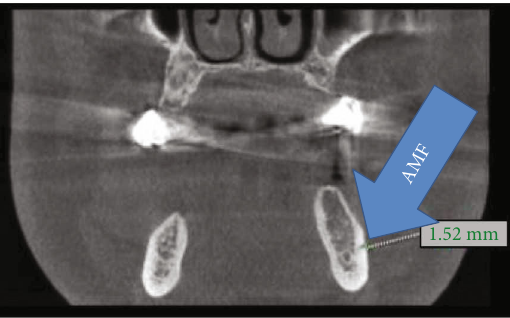
Figure 5: Left AMF at coronal CBCT.